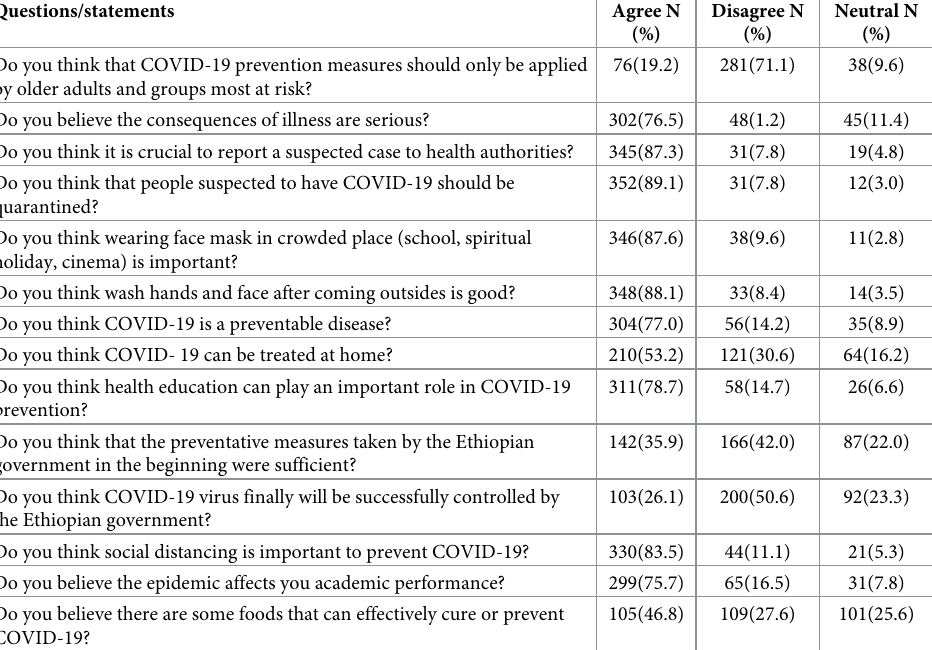
Table 3. Frequency of respondent’s attitude towards COVID-19, among secondary school students in Gondar town, Northwest Ethiopia, 2021.